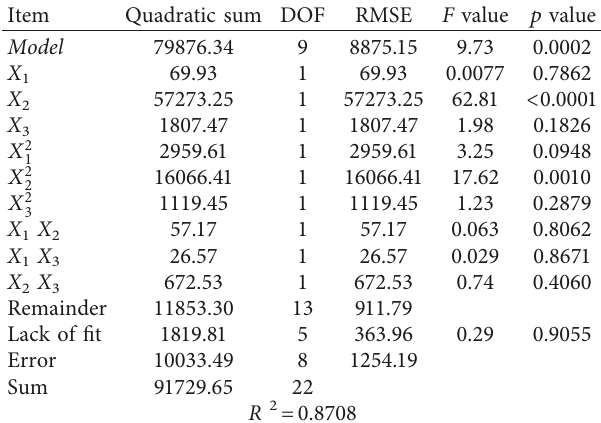
Table 11: Experimental analysis of variance table on relative unit consumption